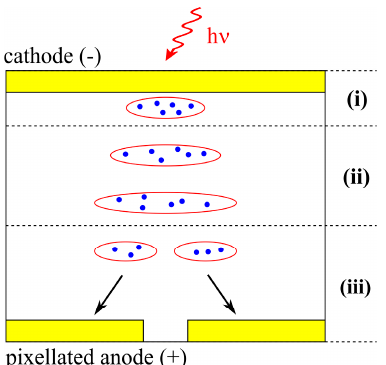
Figure 1. Scheme of the formation and propagation of the electron cloud in the detector illustrating the charge sharing effect.